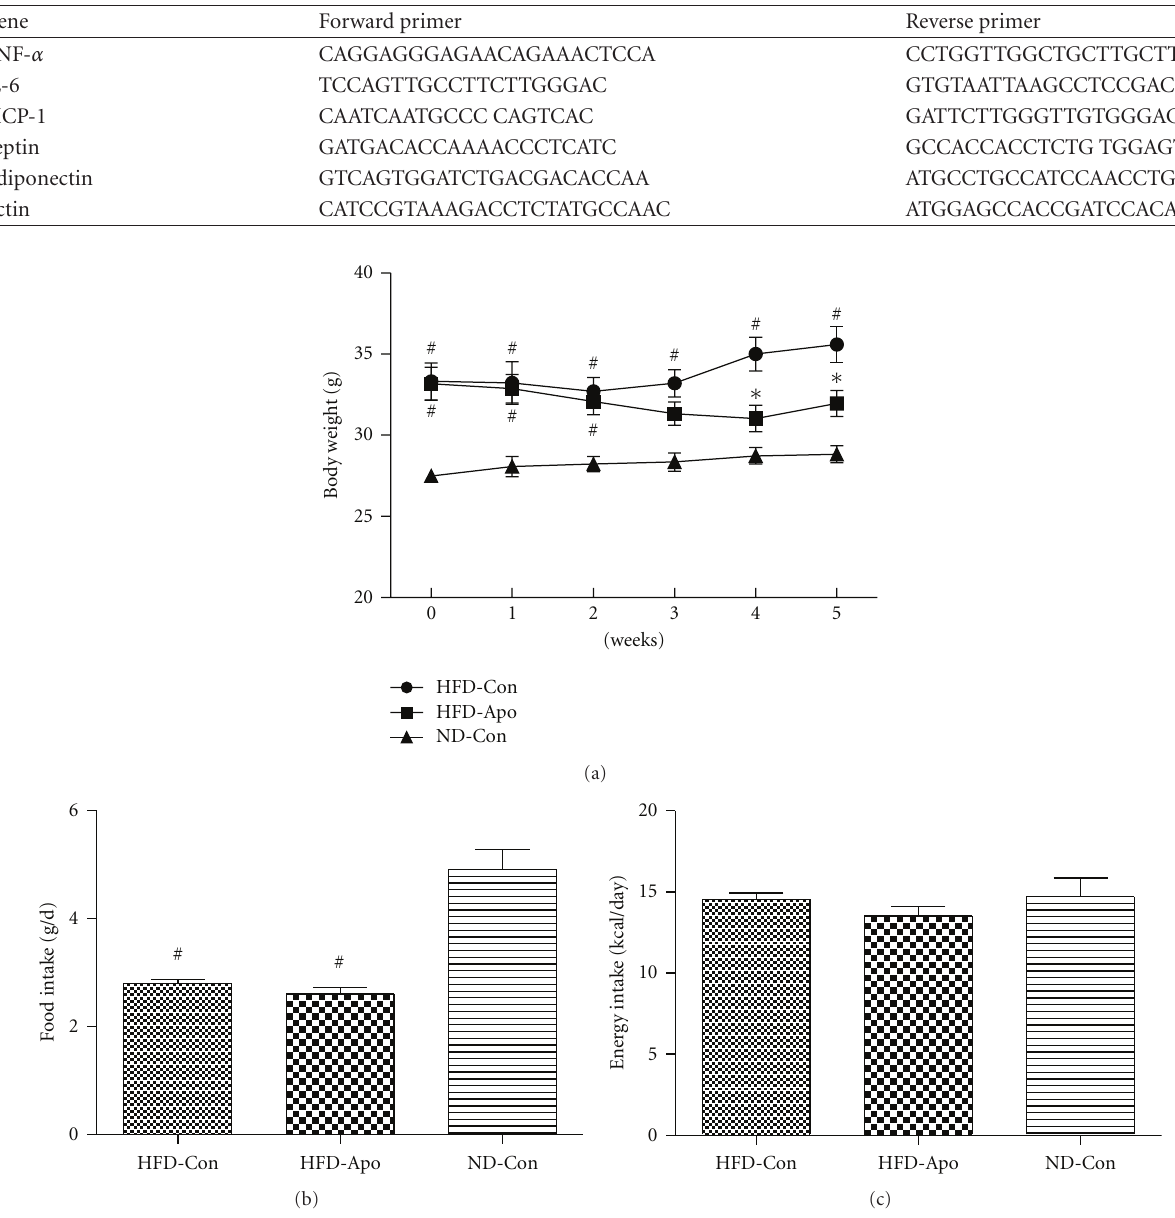
Figure 1: E ff ect of apocynin on body weight, food intake, and energy intake. C57BL/6 mice were fed with HFD for 12 weeks to induce insulin resistance. After 12 weeks of feeding, the HFD-fed mice were divided into two groups. The HFD-fed mice in one group were treated with apocynin (2.4g/L) in drink water (HFD-Apo, n = 6) for another 5 weeks HFD feeding; the HFD-fed mice in the other group were employed as HFD controls (HFD-Con, n = 6). Normal control mice were fed a normal diet and untreated with apocynin (ND-Con, n = 6). (a) Body weight of three groups. The body weight of the HFD-Apo group was lower than that of the HFD-Con group since the fourth week after apocynin treatment. (b) Food intake. The food intake of the HFD-Apo group and HFD-Con group were lower than that in the ND-Con group. (c) Energy intake. There are no di ff erences among groups. # P < . 05 versus ND-Con group, ∗ P < . 05 versus HFD-Con